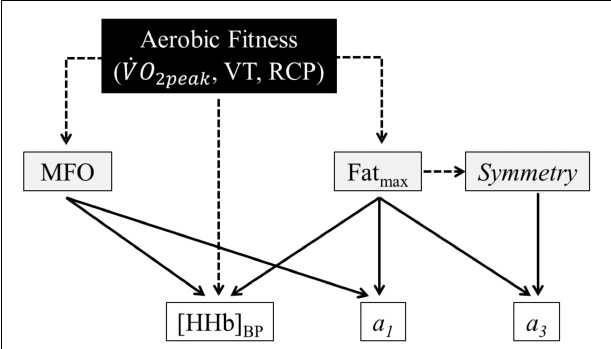
FIGURE 3 | Schematic representation of the correlations among aerobic fitness [peak oxygen uptake ( ˙ VO 2 peak ), ventilatory threshold (VT), and respiratory compensation point (RCP)], whole-body fat oxidation kinetics [maximal fat oxidation (MFO) and exercise intensity at which MFO occurs (Fat max ) and the symmetry variable], and muscle deoxygenation kinetics [the slopes of the first ( a 1 ) and second ( a 3 ) parts of the curve of the double linear